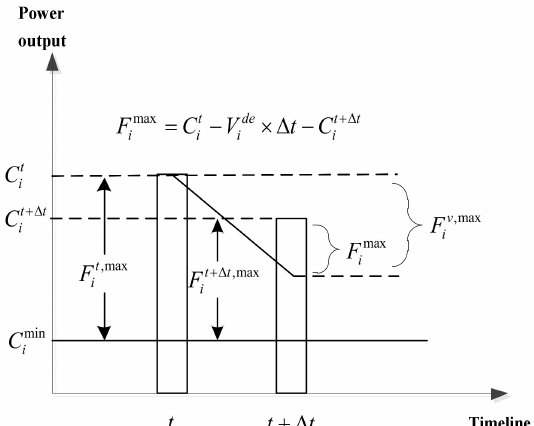
Figure 4. Maximum planned power adjustment amount, with su ffi cient adjustable capacity when reduction of power supply is required.